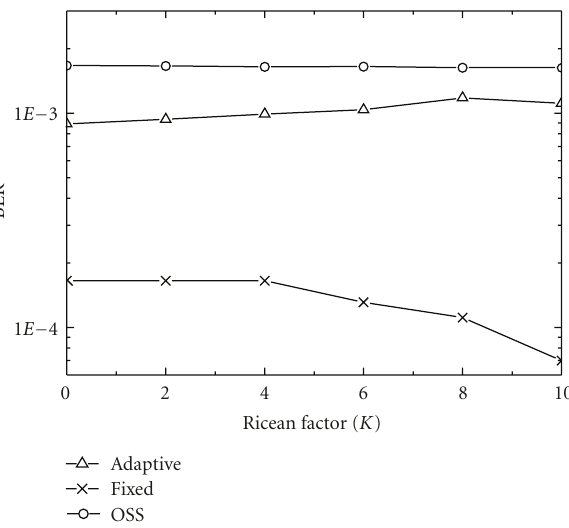
Figure 11: BER performance as a function of Ricean factor, K